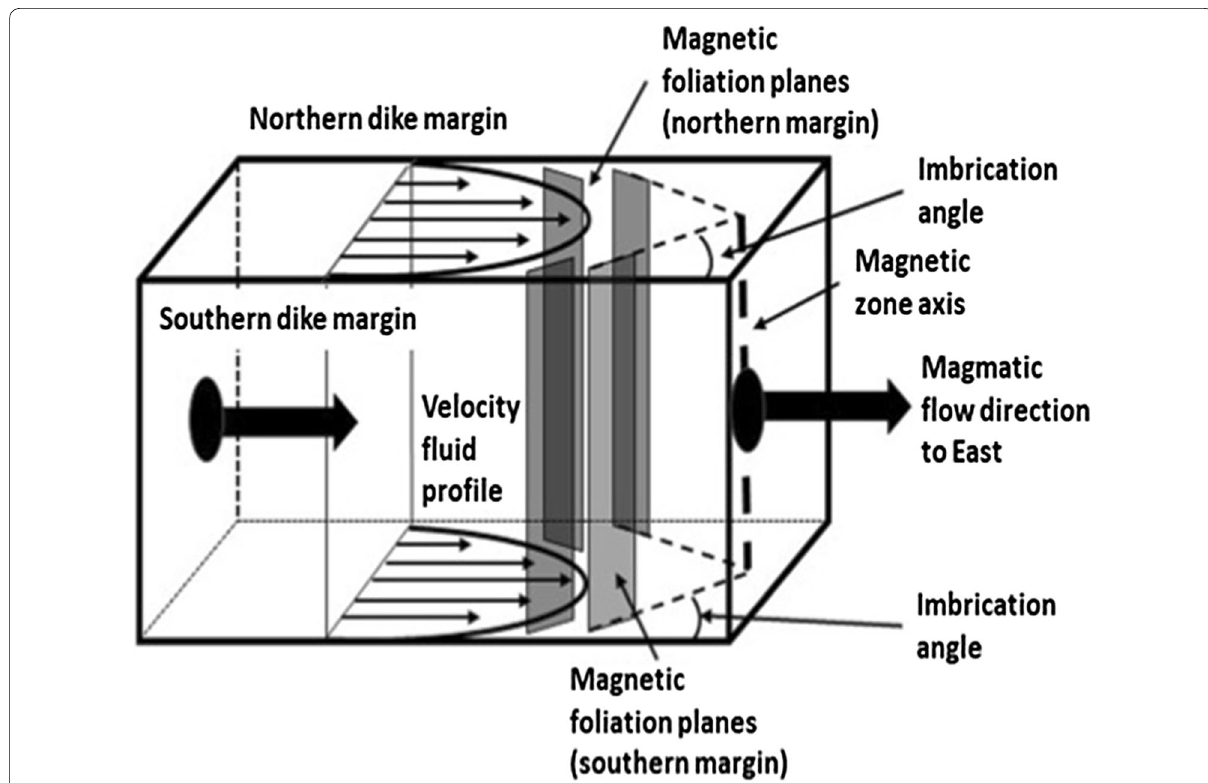
Fig. 6 Determination of the flow direction in dikes using magnetic imbrication angles. Assuming a Newtonian laminar flow without along‑plane displacement of the borders (mode I dike of Knight and Walker 1988), near a dike margin, the flow induces a strain regime characterized by simple shear. So, even with low particle concentrations the phenocrysts would interact and align their long axis predominantly along with the flow direction, in a plane parallel or making a small imbrication angle with the dike margin. Magnetic particles that form and develop between the phenocrysts will replicate the orientations and alignments of the phenocrysts. Considering a normal magnetic fabric, the magnetic foliation planes near the borders will be coincident with the particle’s imbrication planes. Therefore, the flow sense can be specified for cases with clearly visible imbrication on both dike borders